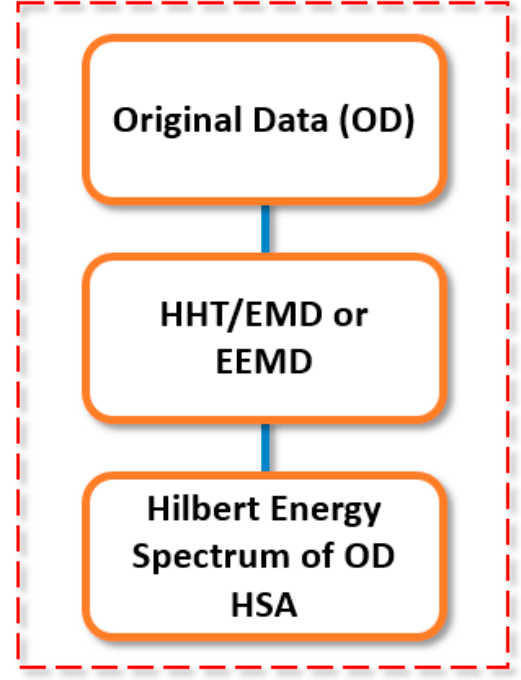
Figure 7. HHT calculation process.